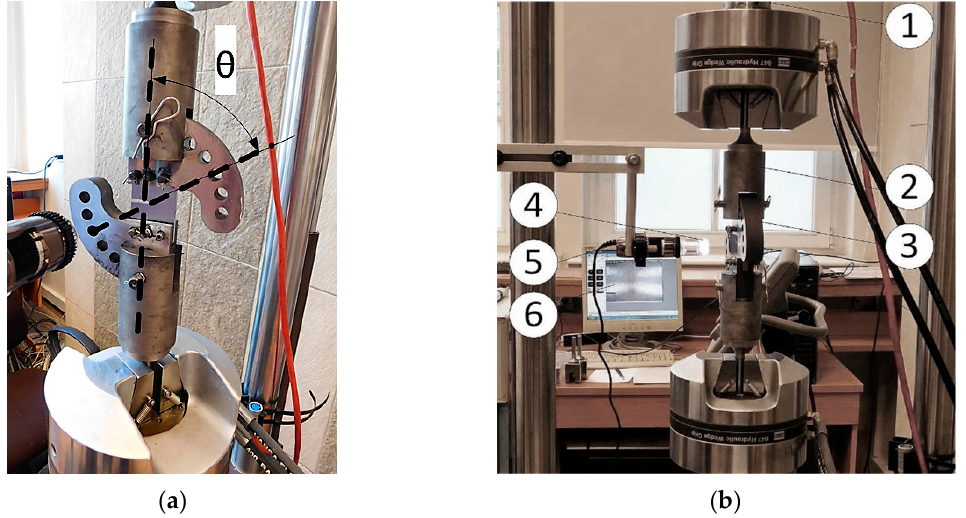
Figure 4. Experimental mixed-mode I + II loading test: ( a ) Definition of load angle, θ ; ( b ) measurement stand: 1—load cell, 2—gripping system, 3—CTS clevis, 4 – light source, 5—digital microscope, 6—imaging system.